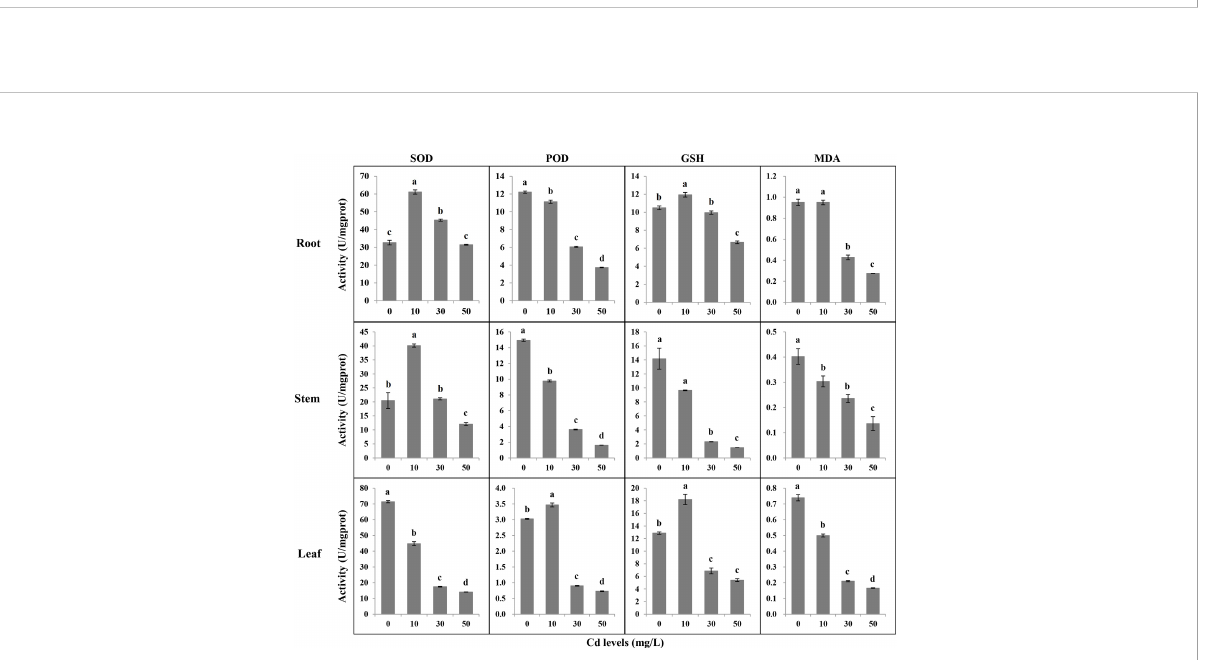
FIGURE 3 The antioxidant activities and malondialdehyde content in different tissues of Tartary buckwheat seedling after 7-day treatments. SOD, superoxide dismutase; POD, peroxidase; GSH, glutathione; MDA, malondialdehyde. Different lowercase letters on the top of bars indicate signi fi cant differences between treatments according to Duncan t -test ( p -value < 0.05).